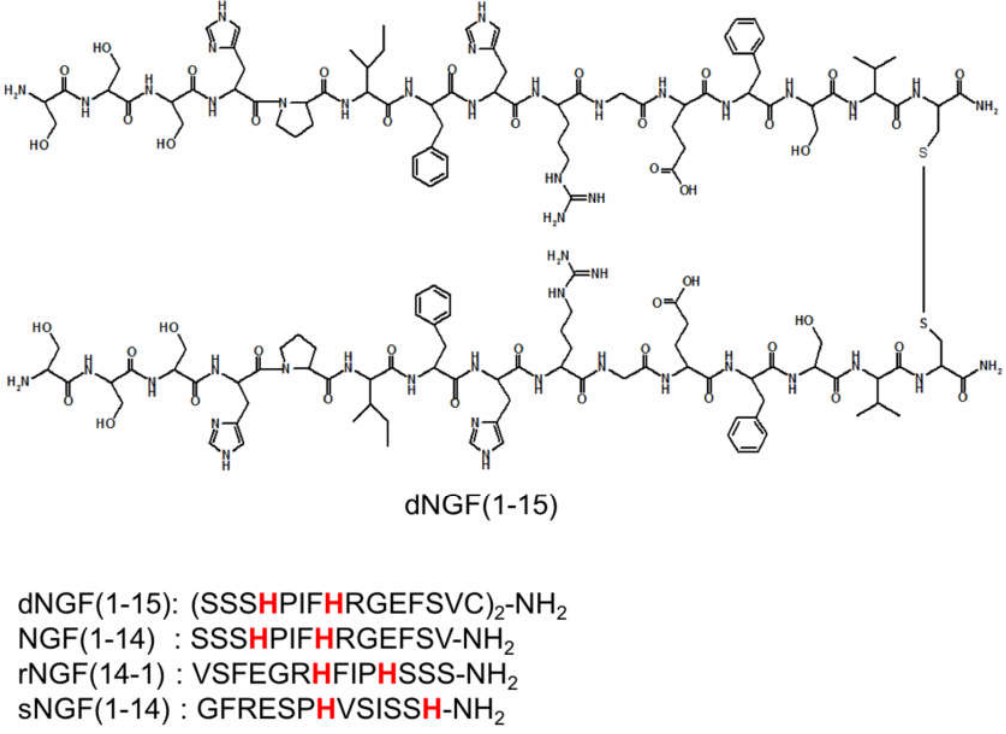
Figure 1. Structure of dNGF(1-15) and primary sequence of NGF N-terminal peptides. In red histidine residues that can act as metal anchoring sites.